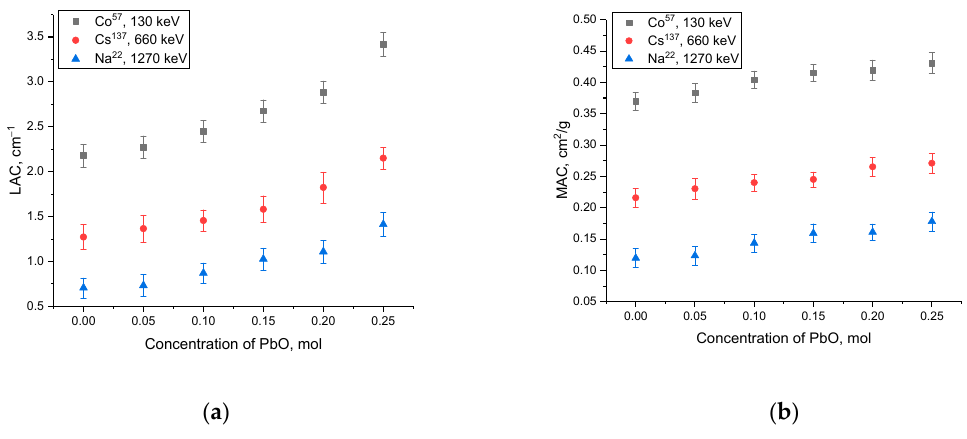
Figure 14. Shielding performance results: ( a ) linear absorption coe ffi cient change data; ( b ) mass absorption coe ffi cient change data.